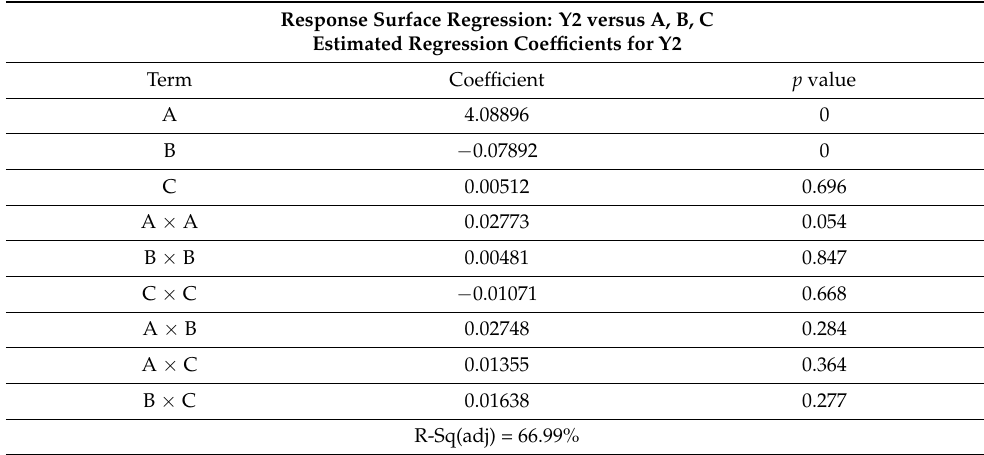
Table 5. Experimental regression analysis for the average fin